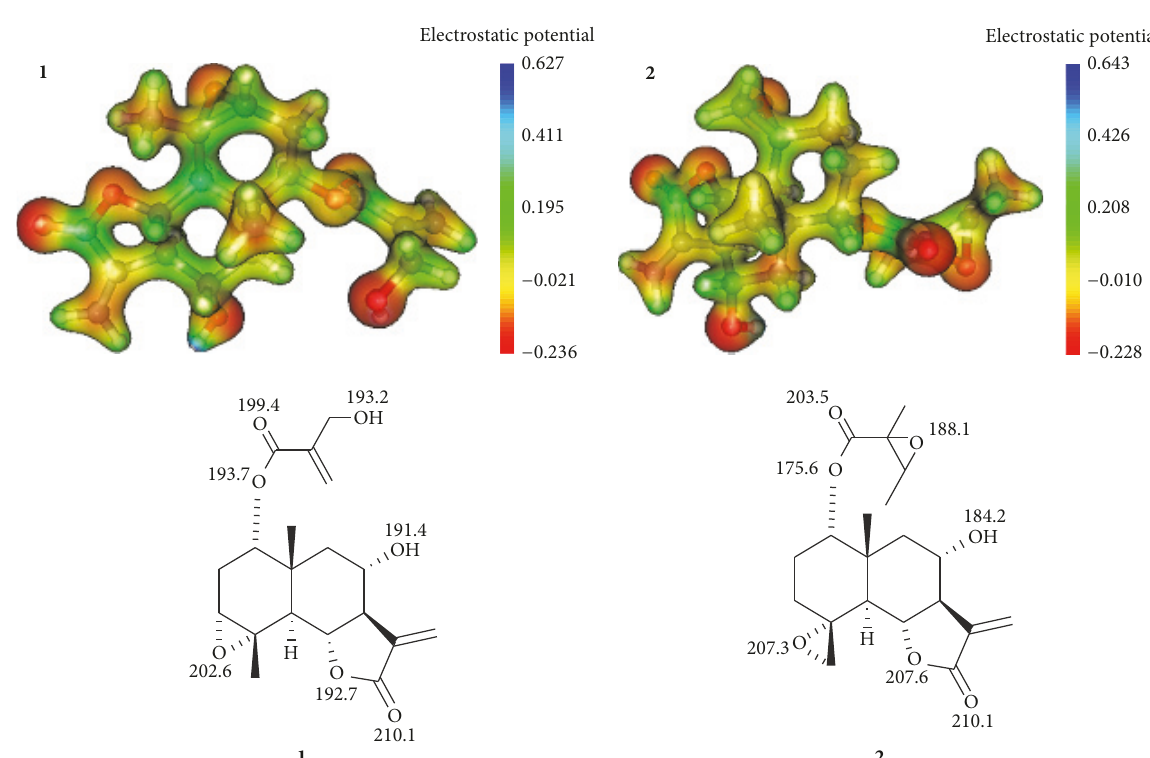
Figure 3: Molecular electrostatic potential maps (MEP) and proton affinity (PA) of epoxyeudesmanolides 1 - 2 . All values of PA are in kcal ⋅ mol −1